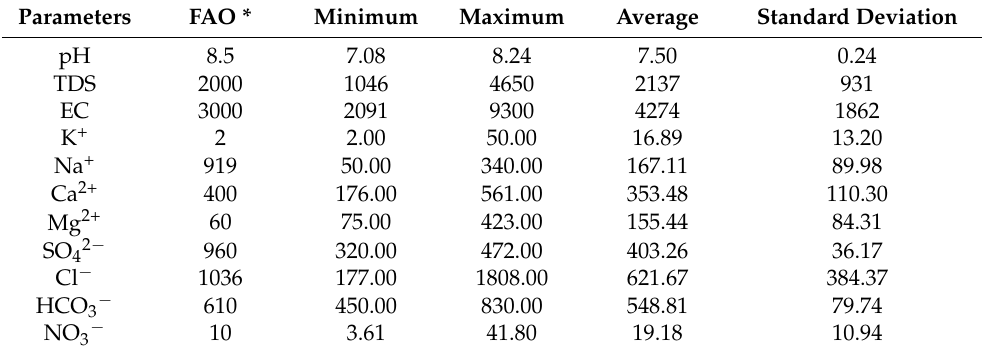
Table 2. Descriptive outcomes of the groundwater samples with the standard limit for irrigation